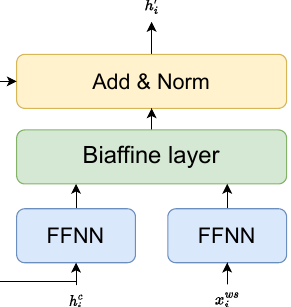
Figure 3. The framework of the Word-level Information Injection Adapter (WIIA). Pairing with the prepossessed corresponding word-level information, the character-level features are the input of WIIA. A biaffine layer is used for fusing the two-level information, and the mixed results are presented with a new eigenvector that is used for subsequent classification tasks after being added with character-level hidden features and layer